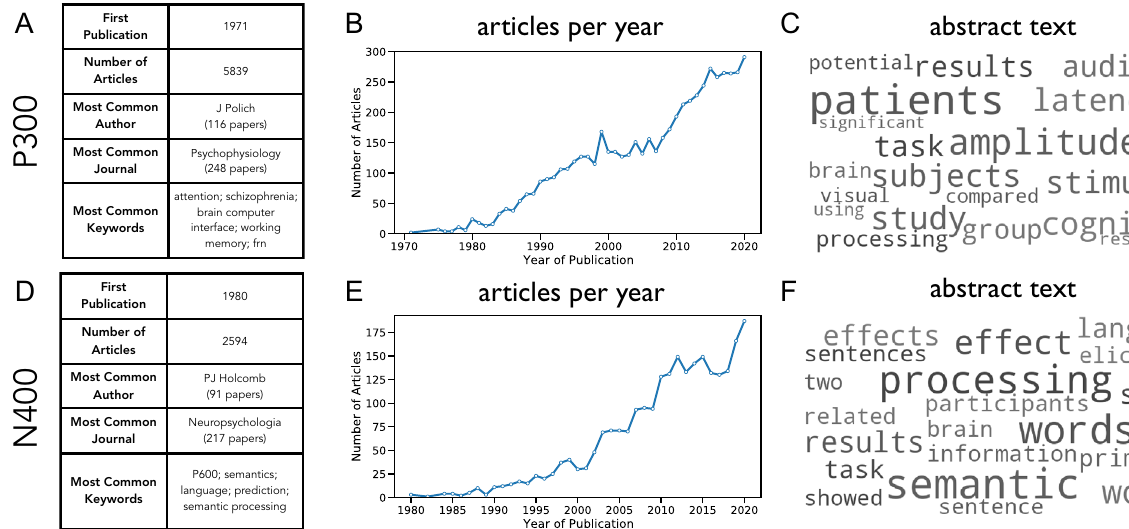
Figure 3. Example ERP profiles. Profiles for the P300 ( A – C ) and N400 ( D – F ) are created from text and metadata collected from all identified articles related to these components. ( A ) Summary statistics and metadata about articles on the topic of the P300. ( B ) The number of articles published per year for the P300. ( C ) The distribution of the most common words from the abstracts of articles about the P300, represented as a wordcloud. ( D – F ) Same as ( A – C ), but for the N400. Summaries for all ERP components are available on the project website (https:// erpsc anr. github.